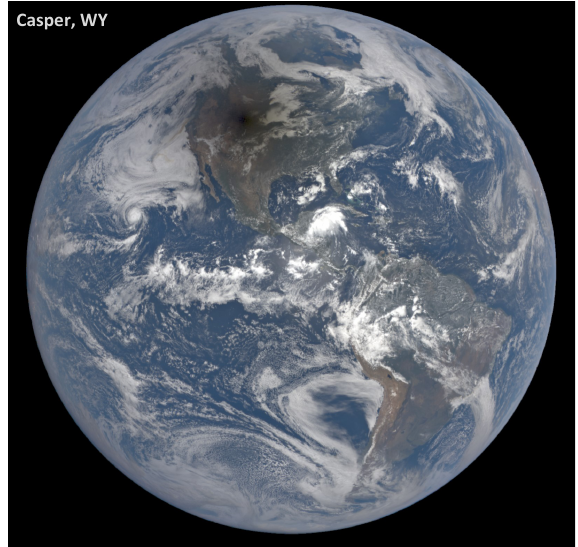
Figure 1. Synoptic view of the sunlit Earth perturbed by the 21 August 2017 total eclipse centered over Casper, Wyoming, at 17:44:50UTC. The black region is the eclipse umbra centered over Casper, WY. The color image has been adjusted from the images on https://epic.gsfc.nasa.gov/ (last access: 18 July 2018) by increasing the gamma correction (Cescatti, 2007) to bring out the region of totality and surrounding